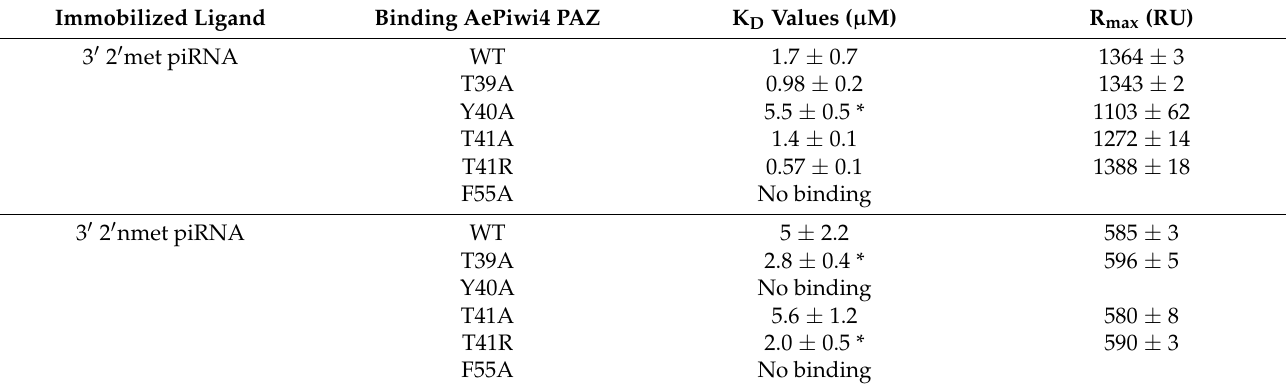
Table 1. Summary of disassociation constants for AePiwi4 PAZ mutants binding 3 (cid:48) 2 (cid:48) O-methylated (met) or non-methylated (nmet) piRNA. Equilibrium K D was calculated from steady-state binding levels R eq = (CR max )/(K D + C) + offset, where C = concentration, R max = analyte-binding capacity of the surface in response units (RU), K D = dissociation constant, and offset = response at zero analyte concentration. * = p ≤ 0.05 by unpaired t-test with WT as comparison